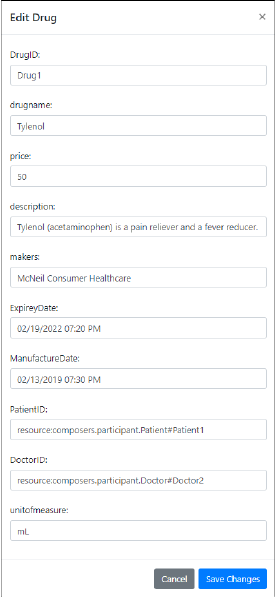
Figure 19. Update drug record.